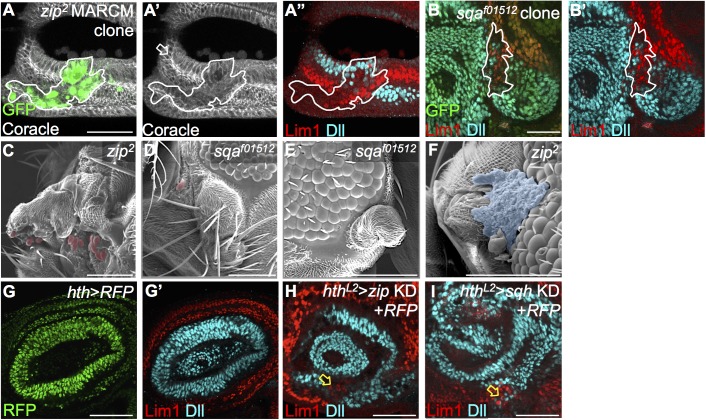
Myosin activity underlies formation of the epithelial fold to ensure lineage restriction.(A-B) zip2 MARCM clone (GFP-positive) and sqaf01512 clone (GFP-negative) show mixing of Lim1 and Dll cells (A” and B’, 18/23 in zip2, 11/15 in sqaf01512, numbers indicates discs with Lim1-Dll mixing/total disc). (A’) Disc morphology is revealed by Coracle (white) staining. White arrow indicates the A1 fold position. (C-E) In adults carrying zip2 or sqaf01512 clones, mislocalized ommatidia (highlighted red in SEM) can be detected in antennal segments (C) or head cuticle (D). (E) Adults with sqaf01512 mutant clones showed antenna-like tissue at the borders of compound eyes. (F) Necrotic-scar like cells were observed in zip2 mutant adults (highlighted in blue). (G-G’) hth-GAL4 expression (RFP, green) completely covers the Lim1 expression field (red) and partially overlaps with Dll (blue). (H-I) Knockdown of zip or sqh by hth-GAL4 from L2 (hthL2: hth-GAL4+tub-GAL80ts, shifted to non-permissive temperature from L2) showed high penetrance of Lim1 and Dll cell mixing (yellow arrow, zip: 24/24; sqh: 21/22). Scale bars: 50μm, except C-F: 100μm.